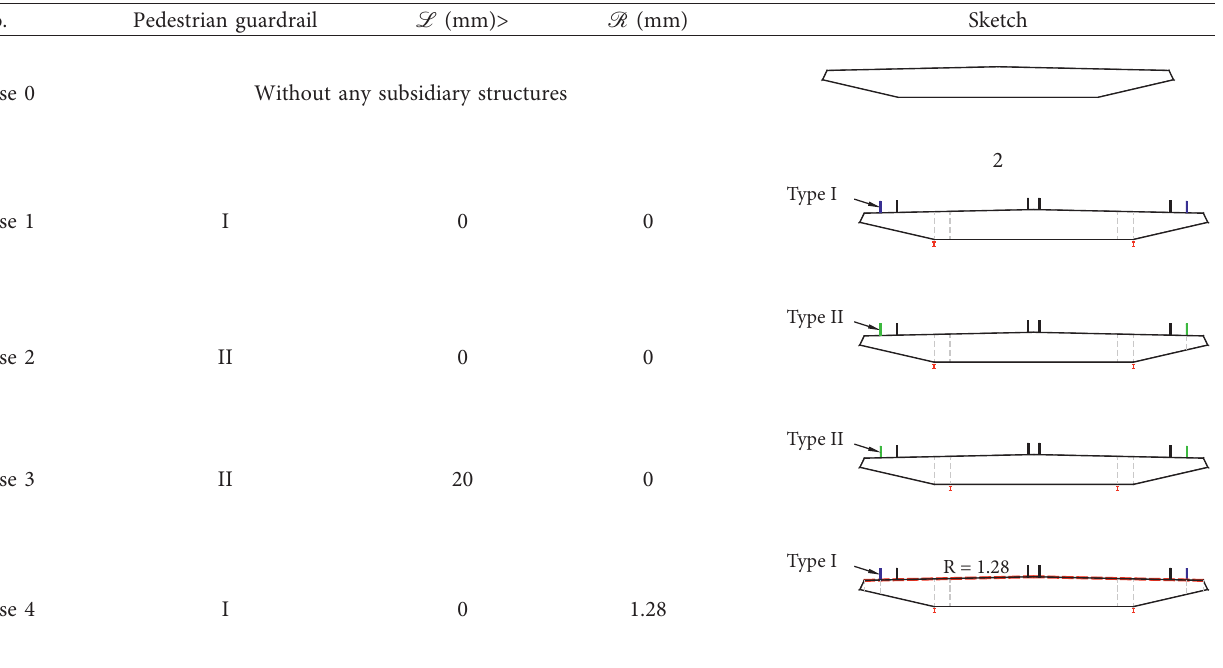
Figure 4: Comparisons of measured and recommended turbulence power spectra at the girder height: (a) longitudinal component; (b) vertical component. Table 1: Descriptions of testing cases, at 1/60 scaling